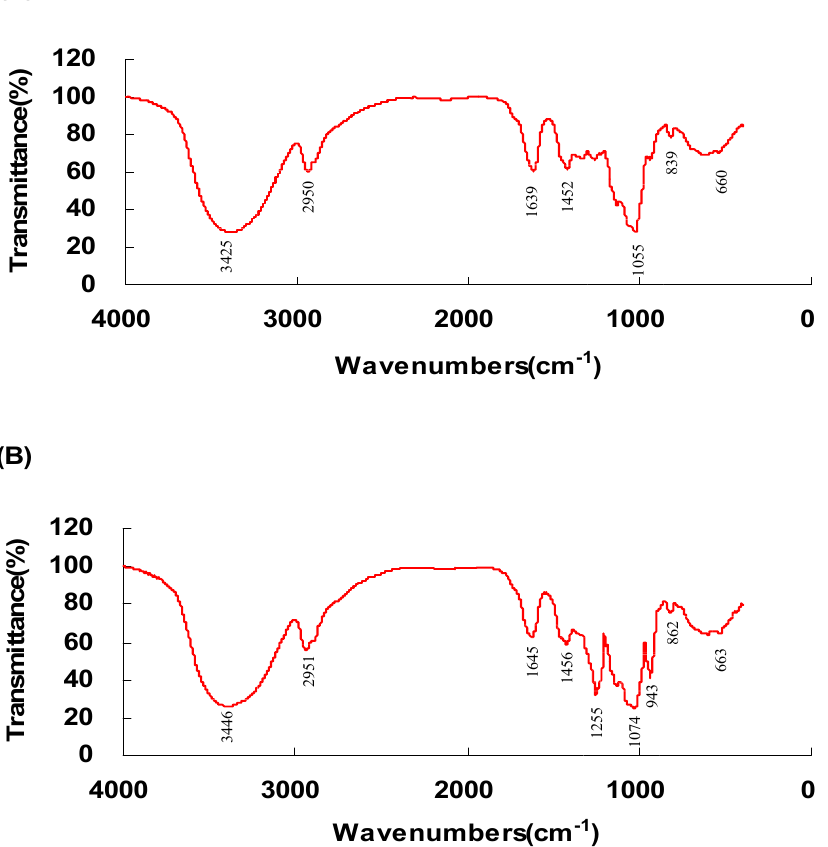
Figure 1. FT-IR spectra of pRCPS. The IR spectrum of the pRCPS powder was analyzed using the potassium bromide pellet method in an IR spectrophotometer. The data were recorded between 4000 and 400 cm − 1 . The IR characteristics of: RCPS ( A ); and pRCPS ( B ) are illustrated.